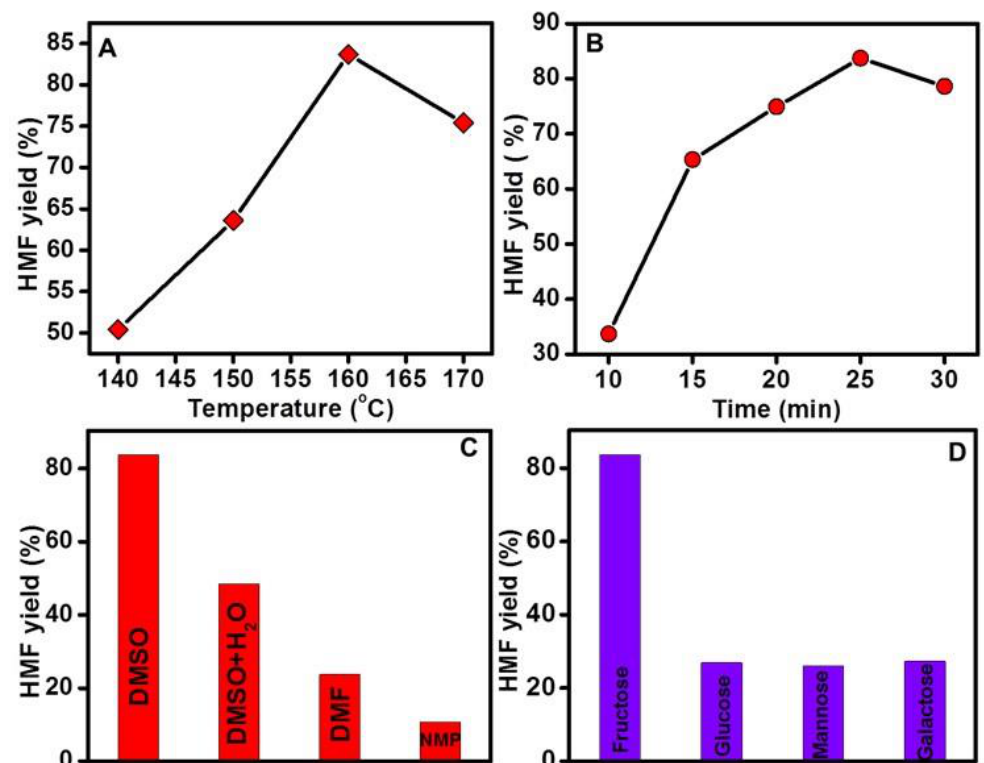
Figure 5. ( A ) Temperature dependence of HMF yield (%). ( B ) Dependence of HMF yield on reaction time (min). ( C ) Solvent dependence of HMF yield (%). ( D ) Selectivity of substrate for HMF conversion reaction. The amount of catalyst used was 3 mg, substrate used was 24 mg and solvent used 2 mL under microwave irradiating conditions. Table 1 . Catalytic activity of PHMS−2 material for HMF production under different conditions .